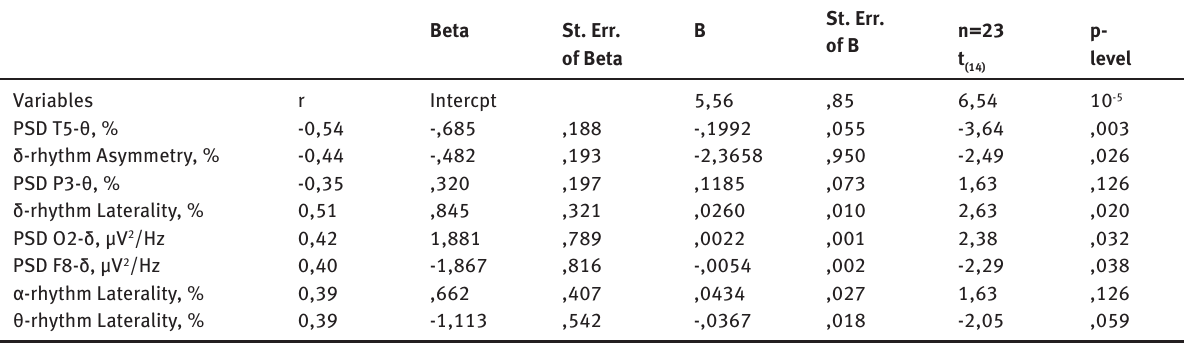
Table 5: Regression Summary for Dependent Variable: Eosinophiles